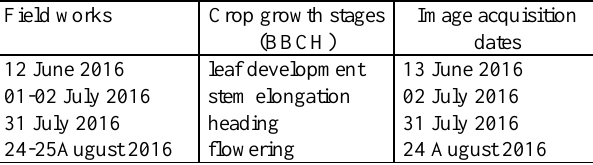
Table 2. In situ measurements of test site